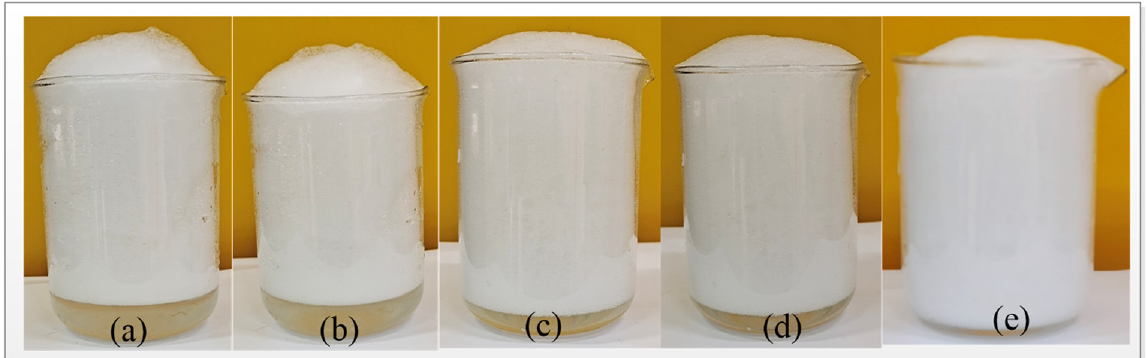
Figure 7. Gel–foams with different mass fractions of foam stabilizers (( a )—0.1%; ( b )—0.3%; ( c )—0.5%; ( d )—0.7%; ( e )—0.9%).